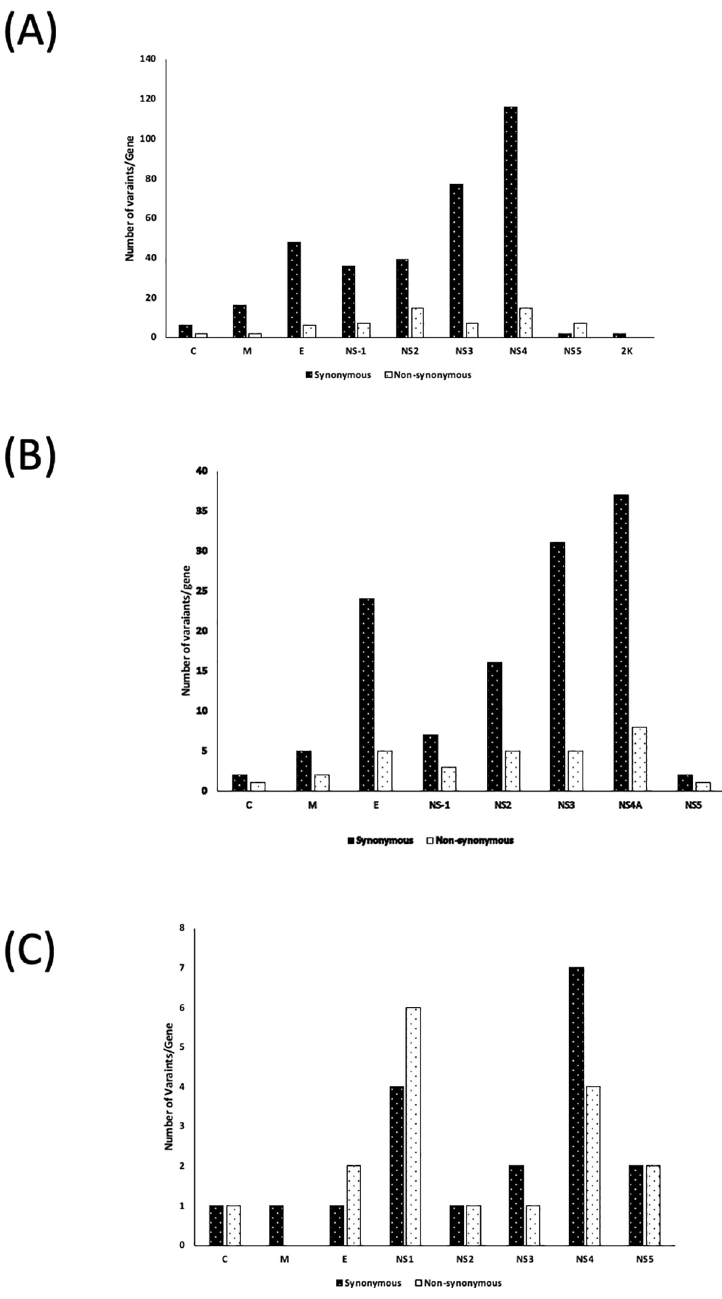
Fig 2. Number of positions with variant incidence > 1% per gene among the DENV-isolates. (A) DENV-1, (B) DENV-3 and (C) DENV-4. stop codon mutation at position 3483 (Q3483 � ) (Table 4). For DENV-3, a total of 154 muta- tions (124 synonymous and 30 non-synonymous mutations) were identified among 7 isolates. Furthermore, 36 mutations (19 synonymous and 17 non-synonymous) were identified among 3 isolates of DENV-4. The non-synonymous mutations among DENV-3 and DENV-4 isolates are shown in Tables 5 and 6, respectively.